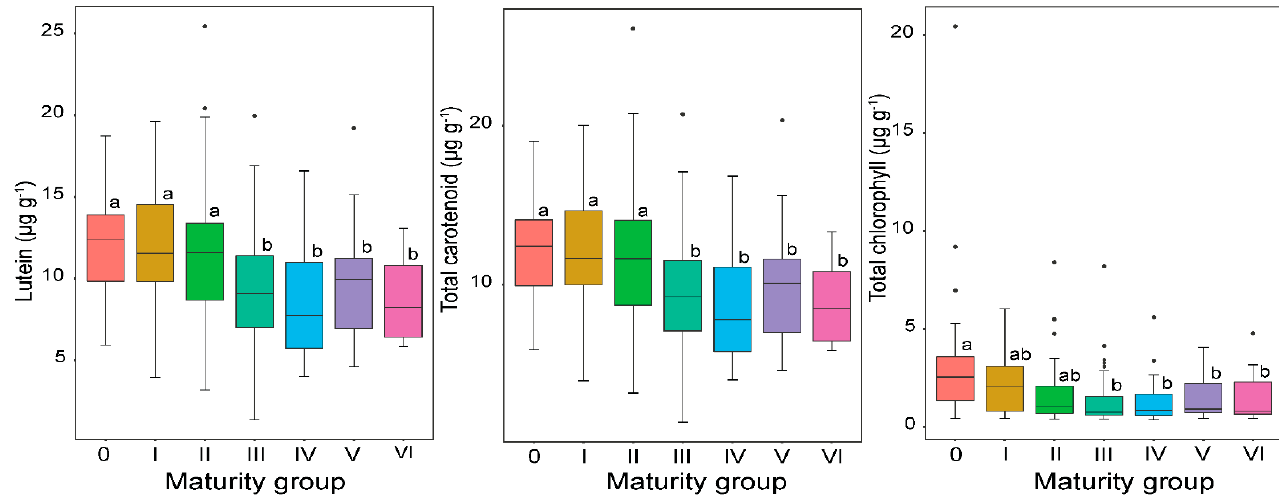
Figure 3. Seed carotenoid and chlorophyll concentrations of yellow-seed-coat-colored soybean accessions of different maturity groups. Different lower-case letters (a, b and ab) indicate statistically significant difference at p < 0.001 level among the maturity groups. Number of accessions in MG 0 = 61, MG I = 57, MG II = 57, MG III = 80, MG IV = 37, MG V = 24 and MG VI = 15. MG represents maturity group.